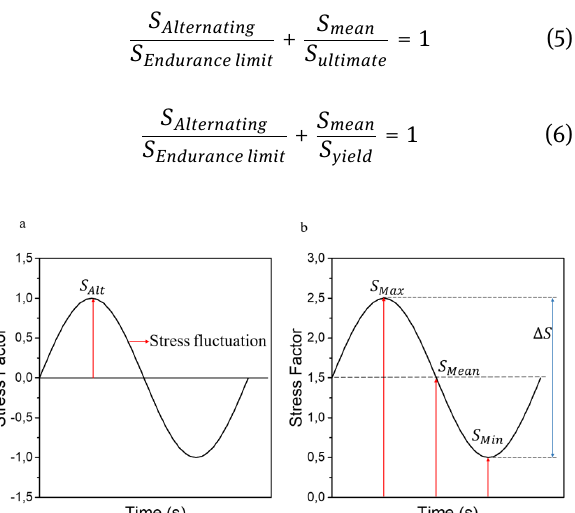
Figure 2. Loading Conditions: a. Zero-Mean; b. Ratio Figure 2: Loading conditions: a. Zero-mean; b.